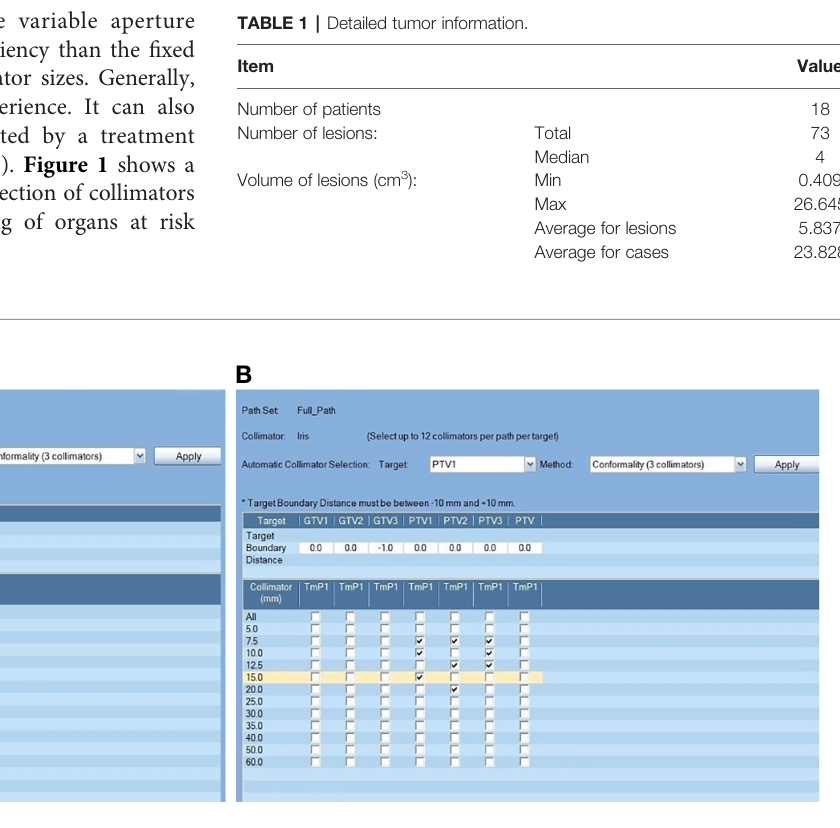
FIGURE 1 | Comparison of two different treatment planning approaches. Lesions were targeted separately (A) or all of the lesions were included in a single PTV (B) ; the “ Conformality(3collimator) ” auto-selection method was applied for the two planning approaches in this example.